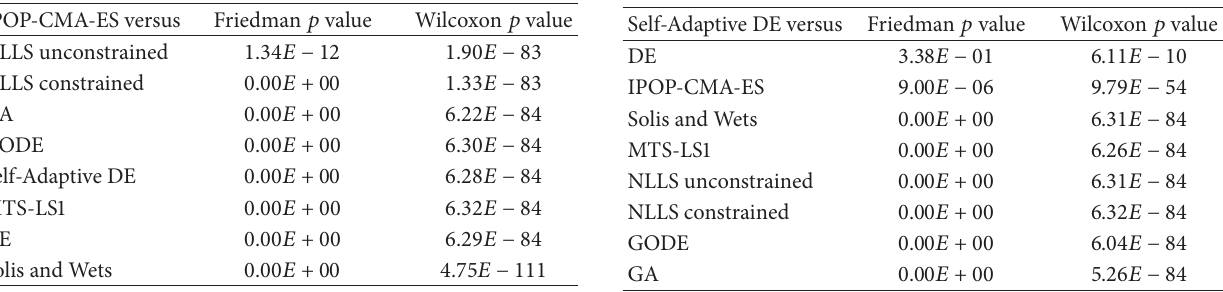
Table 15: Raw 𝑝 values (Self-Adaptive DE is the control algorithm) for the 2-term exponential function.